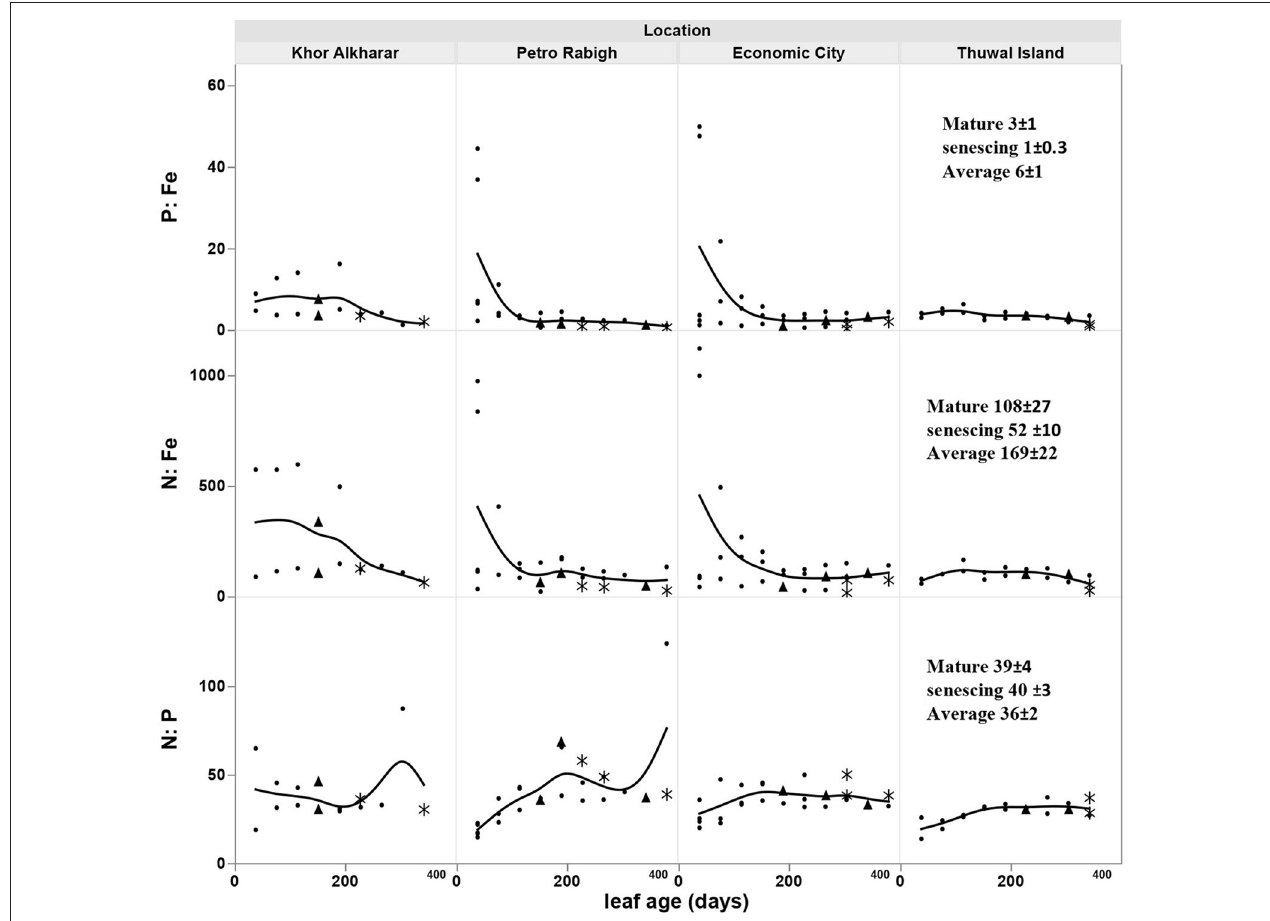
FIGURE 6 | Change in the leaf N: P, N: Fe, and P: Fe ratio with age of Avicennia marina leaves in the Central Red Sea. * for senescing leaves, N for mature leaves. Solid line shows a smoothed line for trees within a